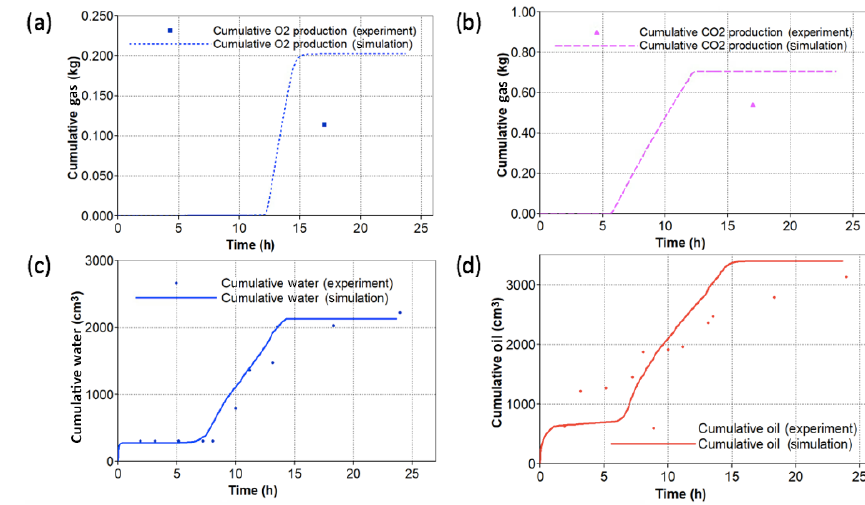
Figure 5. Cumulative O 2 (a) , CO 2 (b) , water (c) and oil (d) production production for experiment and